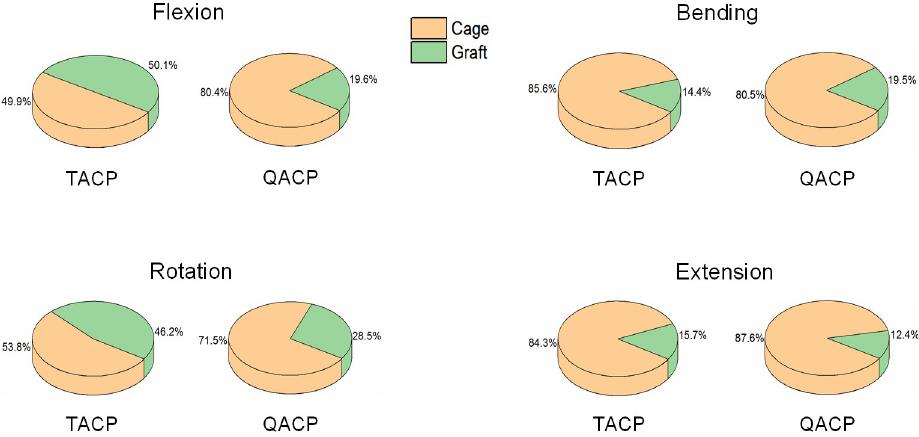
Fig 5. The proportion of stress between the fusion cage and the bone graft during normal exercise in the TACP and QACP implanted spines.